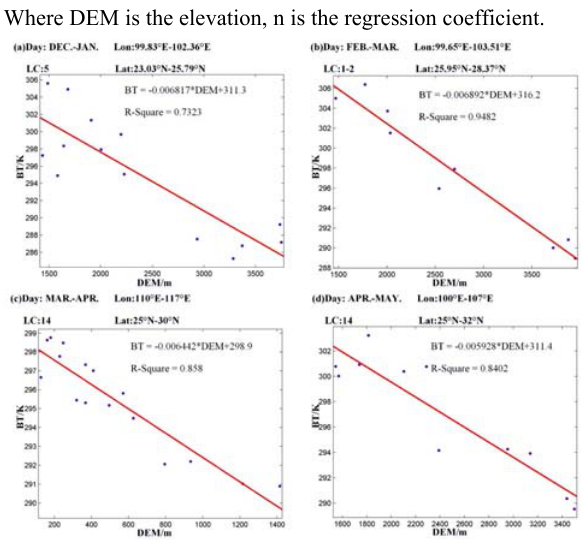
Figure 5. The relationship between BT and elevation Four groups of FY-2 VISSR data from 2006 to 2011 are selected to plot the regression curves shown in Figure 5, which to verify the elevation influence function. In order to make sure the invariance of the group data, the each dataset have a range of latitude and longitude lower than 7 degrees, and a range of days shorter than 20 days, and a range of albedo lower than 0.05, and have the same land cover types. From this figure, we can find that the experiment results of statistical data are very close to the theory result, and the average correlation coefficient reaches 0.85 based on these statistical